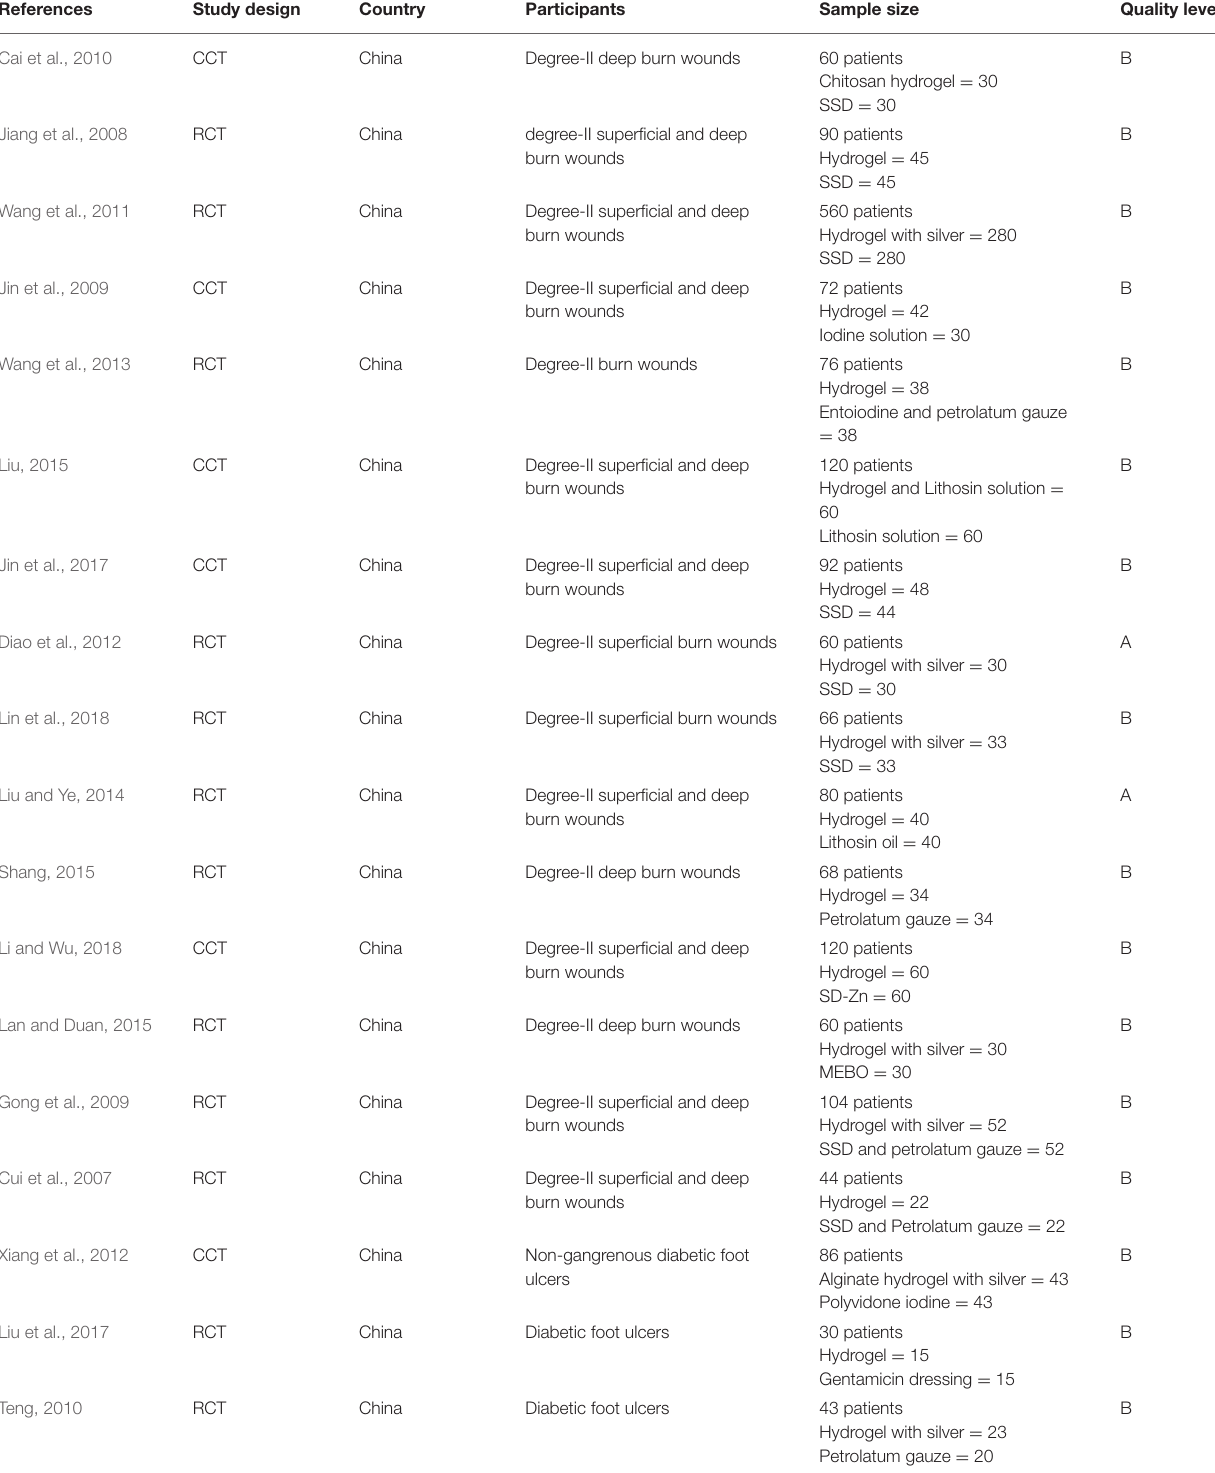
TABLE 2 | Characteristics of the studies employing hydrogel dressings vs. non-hydrogel